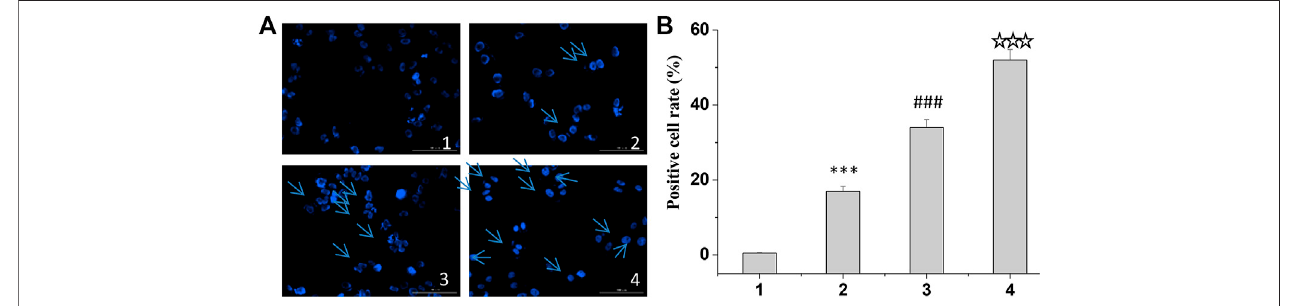
FIGURE5| Hoechststainingofcurcumin/CZLandcurcumin/TPP-CZL.1.PBS,2.curcumin,3.curcumin/CZL,4.curcumin/TPP-CZL.* p < 0.05,** p < 0.01,*** p < 0.001 compared with PBS group; # p < 0.05, ## p < 0.01, ### p < 0.001 compared with curcumin group; p < 0.05, p < 0.01, p < 0.001 compared with CZL group. (A) Hoechst staining of cells (B) Positive cell rate.